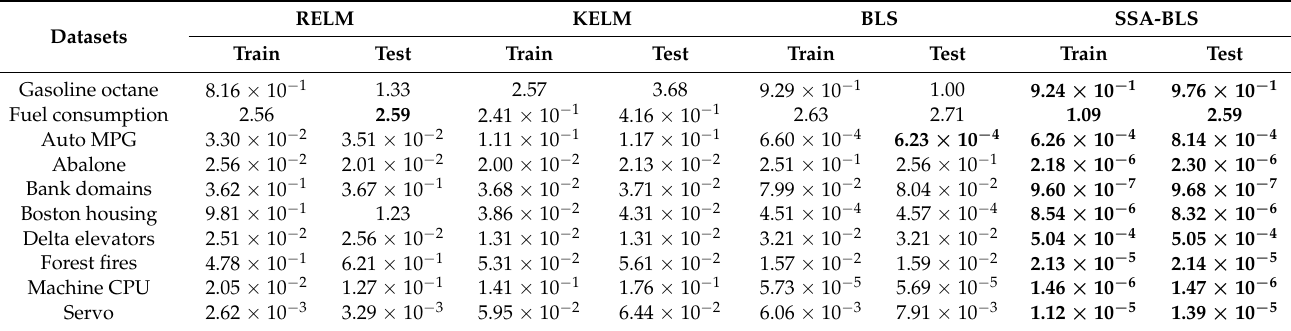
Table 5. The MAPE of the four algorithms on the training set and testing